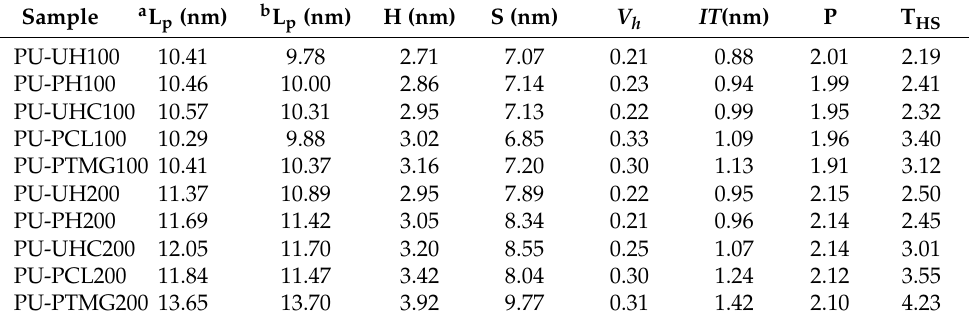
Figure 4. Synchrotron small-angle X-ray scattering (SAXS) patterns for polyurethanes with 1000 (part ( b )) and 2000 (part ( a )) polyol molar mass.